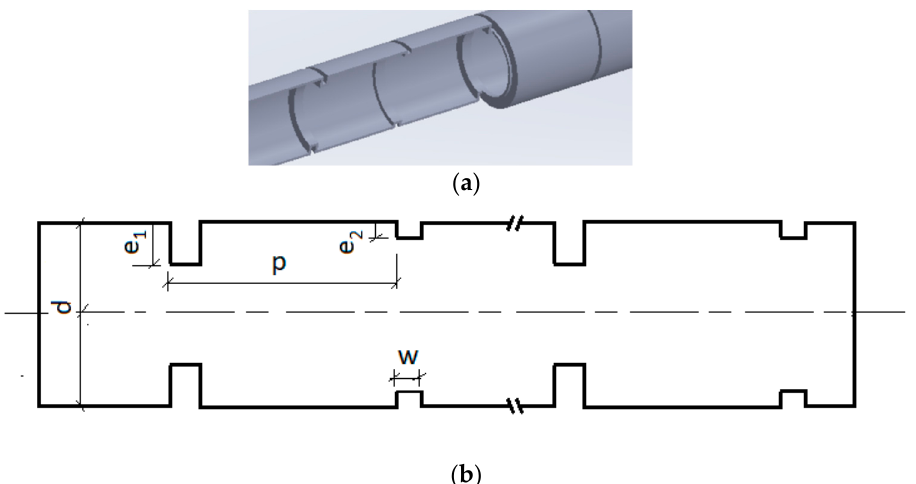
Figure 1. The physical domain of a ribbed tube with a zigzag configuration: ( a ) isometric view; ( b ) front view.